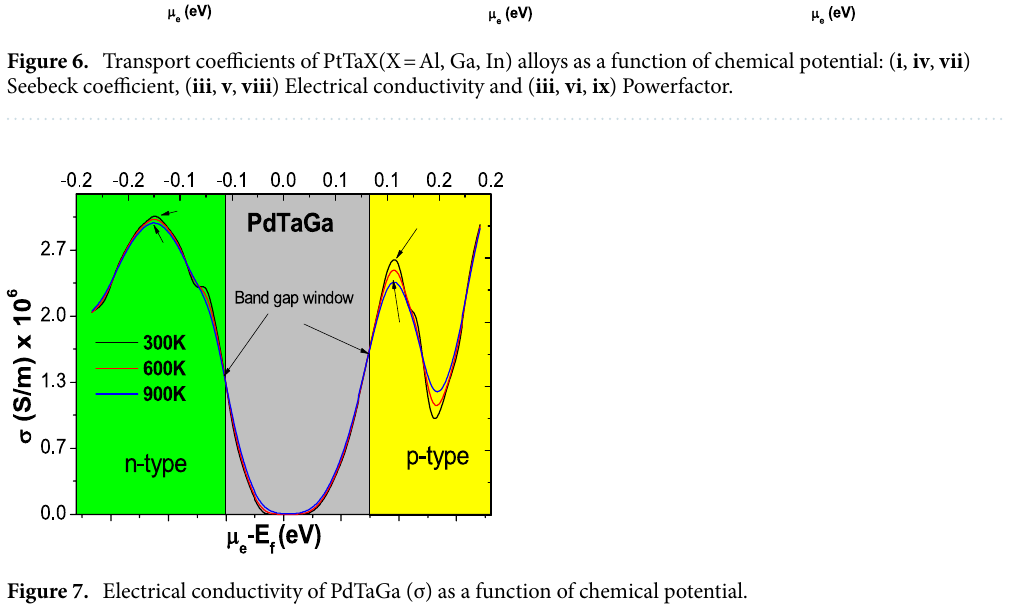
Figure 7. Electrical conductivity of PdTaGa (σ) as a function of chemical